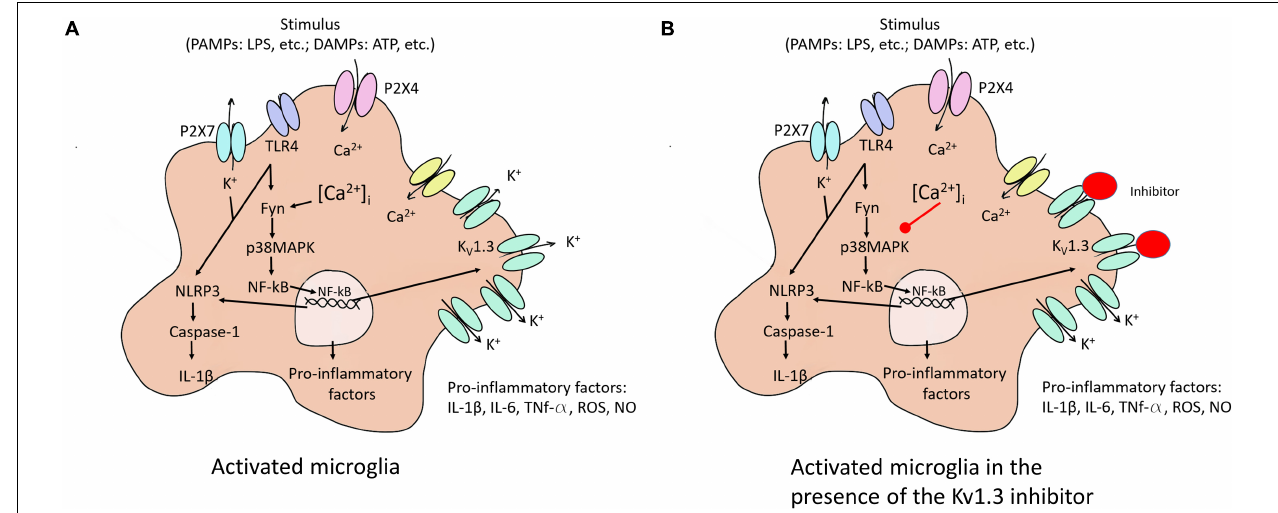
FIGURE 2 | Microglia activation to M1 and the K V 1.3 blockade effect on this activation. (A) Different stimuli activate microglia to pro-inflammatory state (M1). The activation of the NF- κ B pathway induced an increase of K V 1.3 protein in the membrane, among others effects. (B) K V 1.3 inhibitor provokes a smaller Ca 2 + entry reducing secretion of pro-inflammatory factors due to the decrease in the activation of NF- κ B pathway. P2 × 7 and P2 × 4, purinergic receptors; TLR4, toll like receptor 4; NLRP3, NOD-, LRR- and pyrin domain-containing protein 3; PAMPs, exposure to pathogen-associated molecular patterns; DAMPs, endogenous damage-associated molecular patterns; ROS, reactive oxygen species; Fyn, non-receptor tyrosine-protein kinase; IL, interleukin; TNF, tumor necrosis factor; iNOS, nitric oxide synthase, NO, nitric